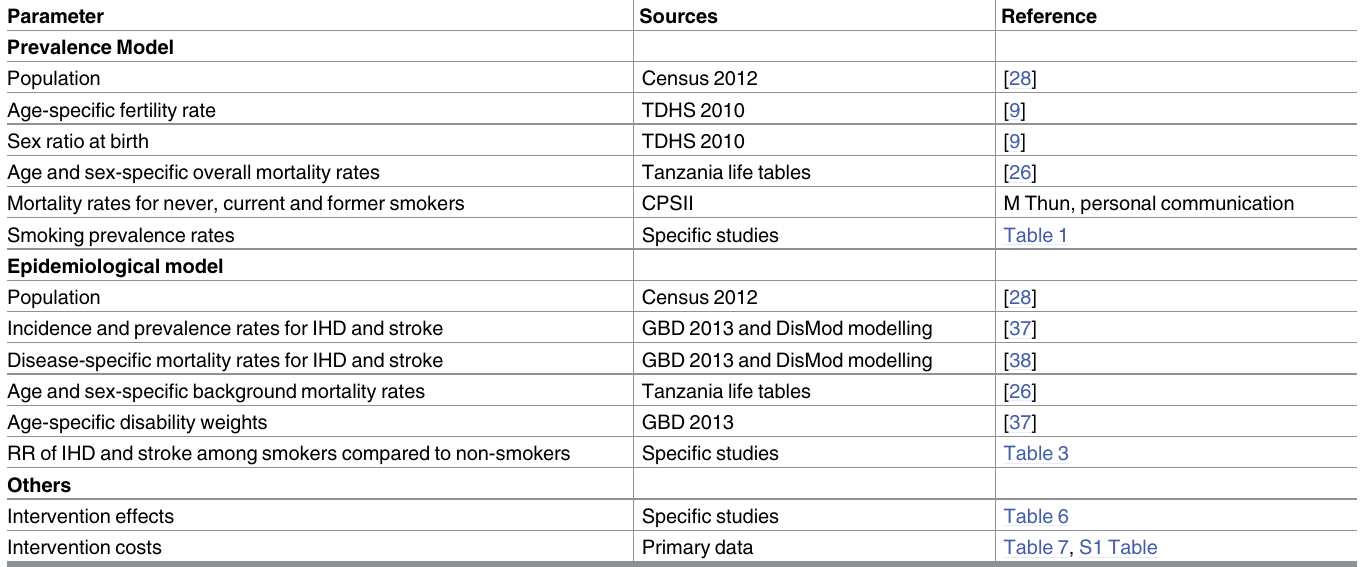
Table 5. Model parameters and data